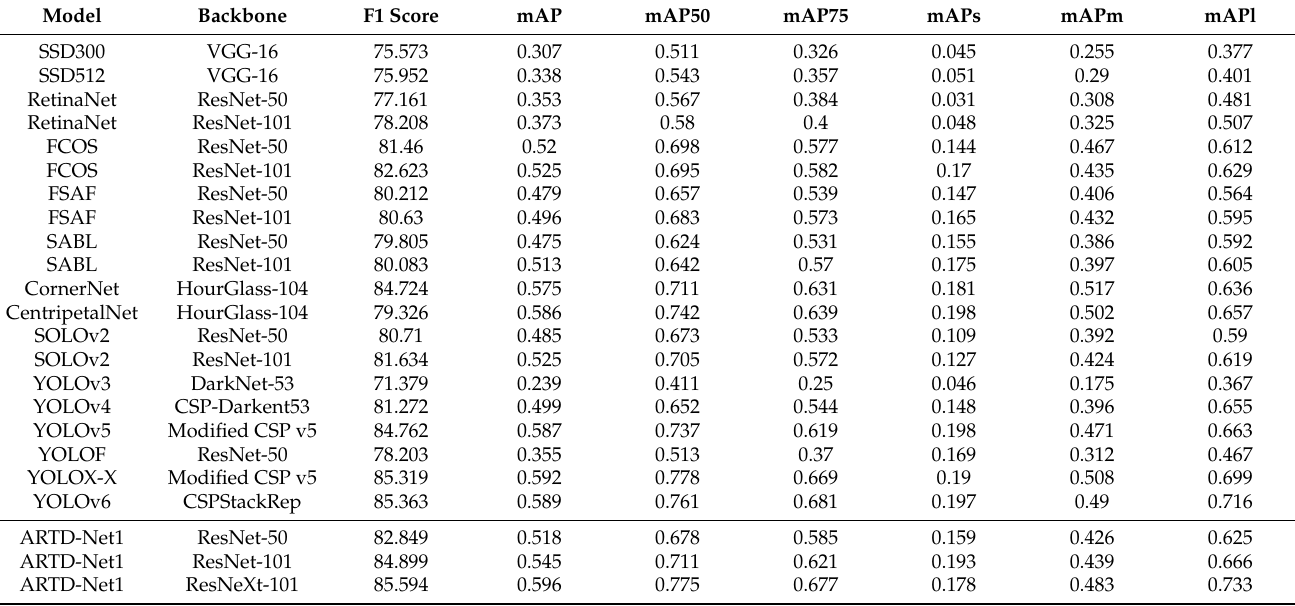
Table 3. Comparison between ARTD-Net1 and other one-stage deep learning models.